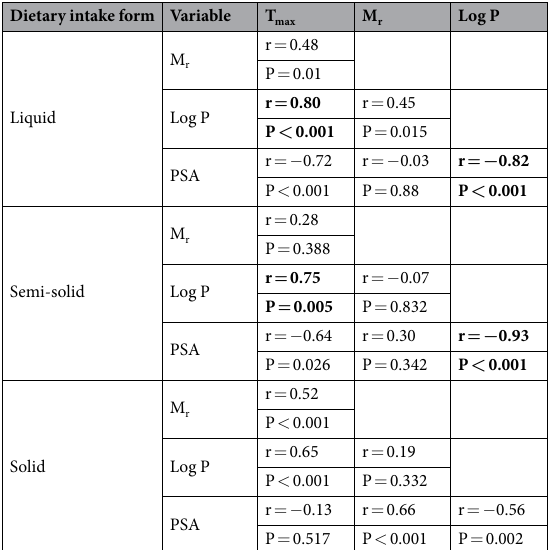
Table 2. Pearson correlations between selected physicochemical properties and T max in the training dataset (N = 67). Data reported as Pearson’s correlation coefficient (r) with P-values. Significantly high correlations (|r| > 0.75, P < 0.05) are highlighted with bold.